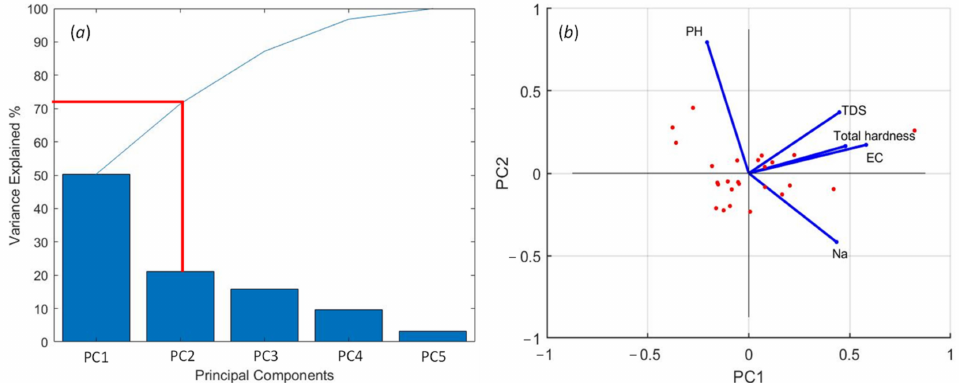
Figure 7. Result of linear PCA: ( a ) percentage of the total variance of X ∗ described by the five principal components (PCs); projection of the measurements onto the plane of first two principal components, PC1 and PC2. Arrows in ( b ) indicate the vectors of PC coefficients associated with the original water quality parameters in the PCs